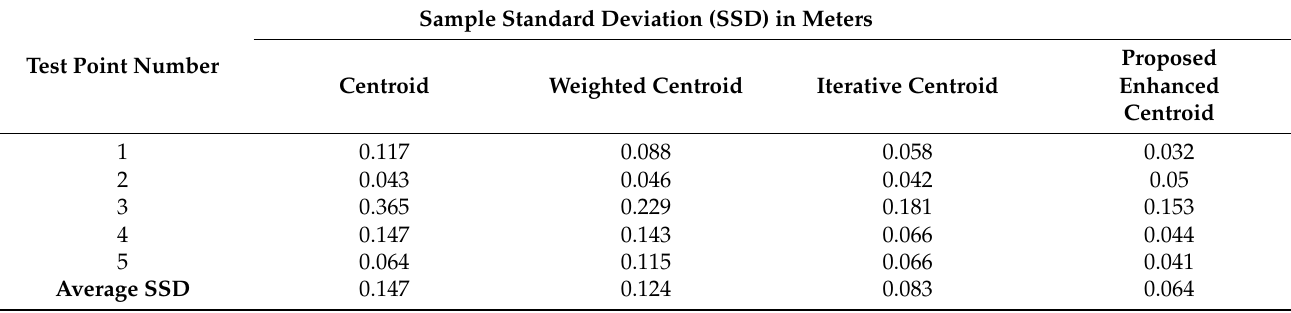
Table 6. The sample standard deviation (SSD) of the four positioning algorithms at five test points in the corridor.